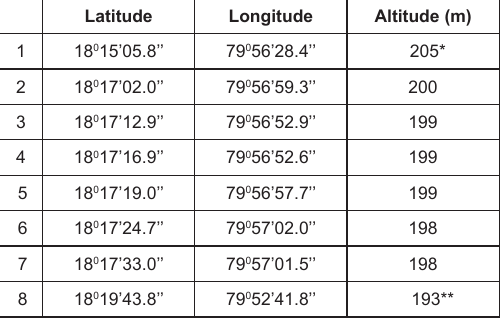
Table 1. New cane patches discovered along the downstream of Ramappa and Morancha